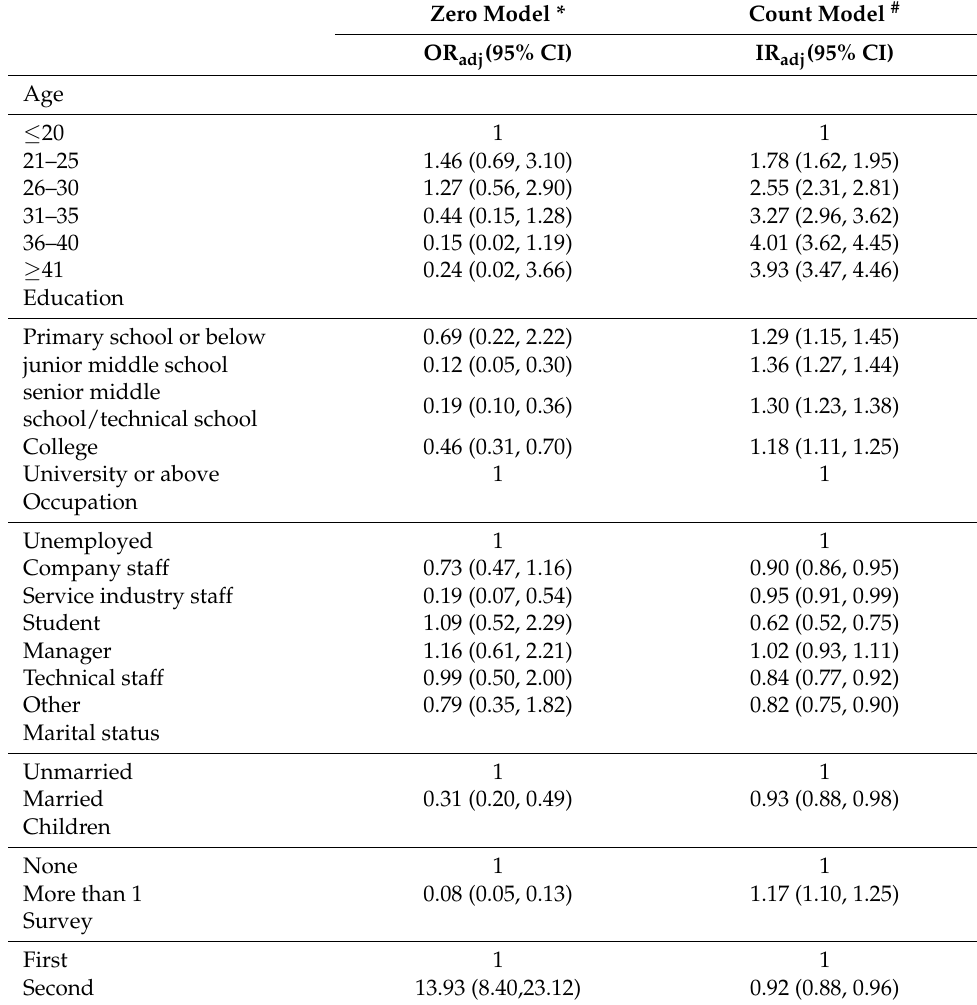
Table 4. Factors associated with repeat induced abortion in multivariable